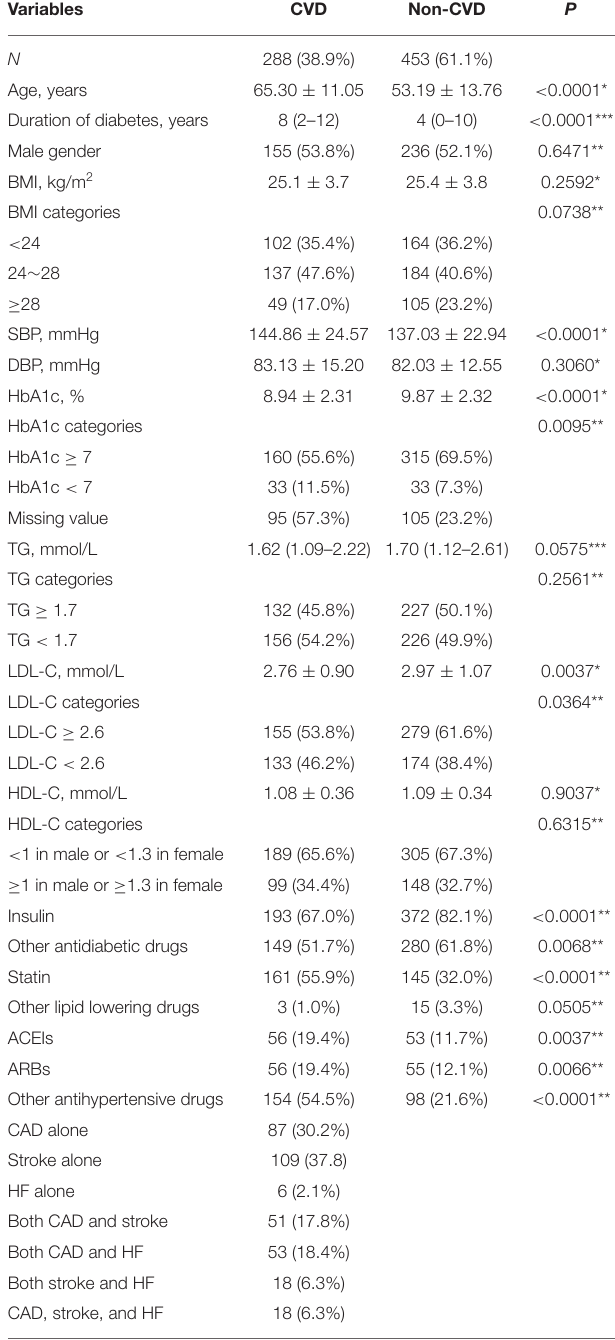
TABLE 1 | Demographic and clinical characteristics of diabetes according to occurrence of